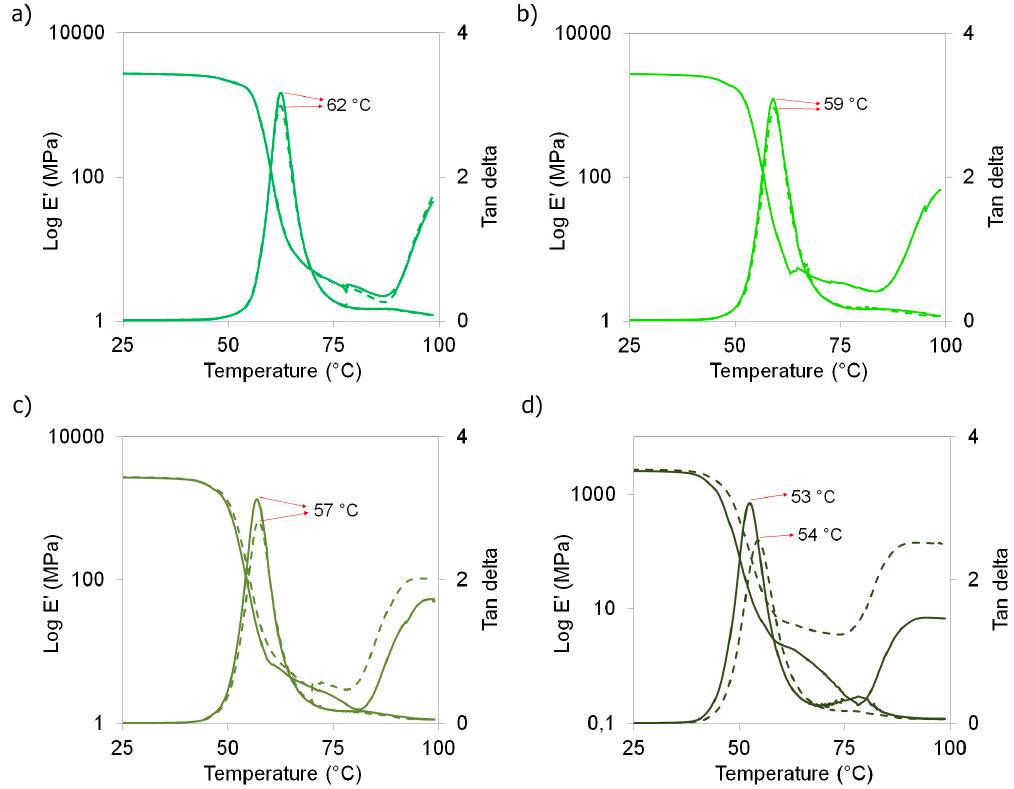
Figure 9. Storage modulus (left Y-axis) and tan delta peaks (right Y-axis) as a function of temperature of PLA nanocomposites (dashed lines) and their respective counterpart materials without nanocrystals (continuous lines). ( a ) unplasticized materials; ( b ) plasticized materials with 2.5 wt % TEC; ( c ) plasticized materials with 5.0 wt % TEC; and ( d ) plasticized materials with 7.5 wt % TEC.